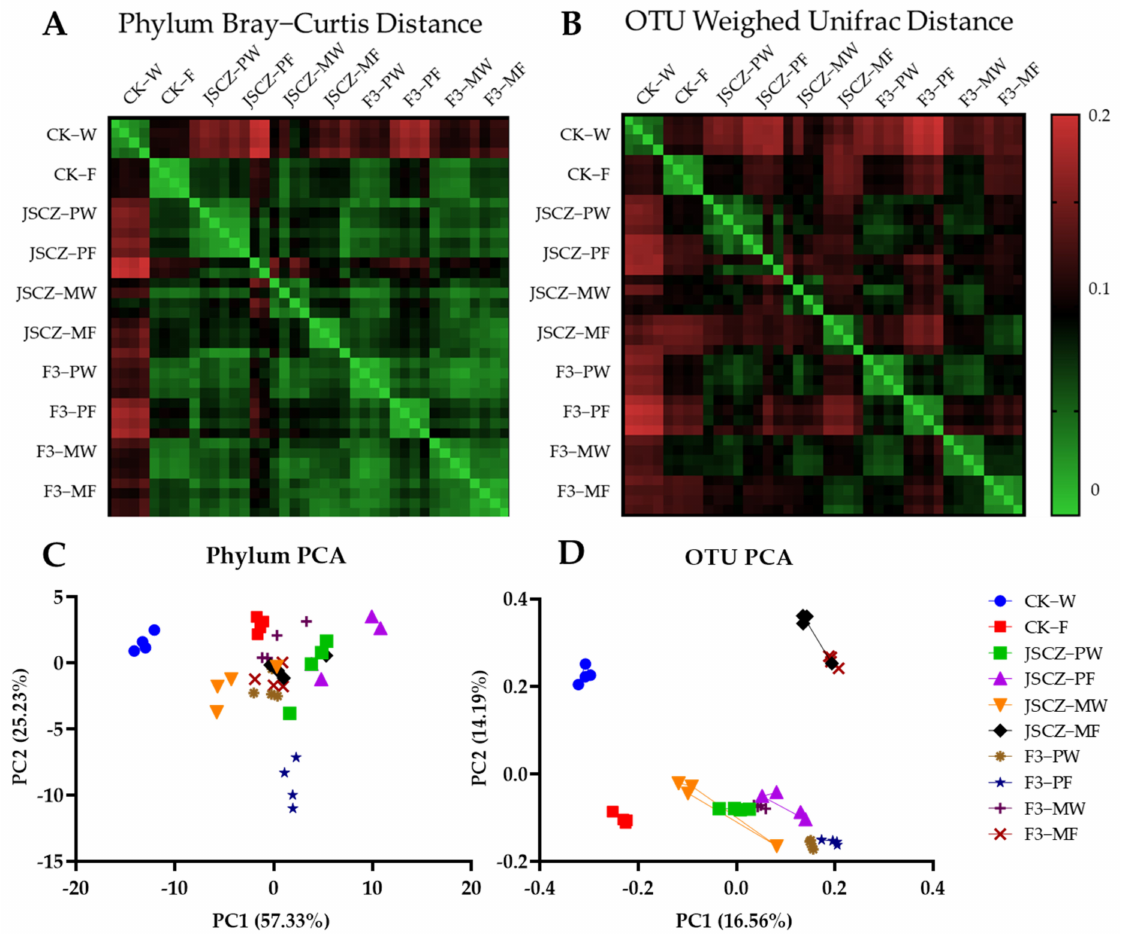
Figure 10. Distance for heatmap ( A , B ) and PCA ( C , D ) in different classification levels of JSCZ and F3. In a comparison among the four planting conditions, the relative abundance of Rhi- zobiaceae and Rhizobium of JSCZ F3 under pure planting conditions in farmland soil was significantly higher than that under pure planting conditions in wasteland soil and